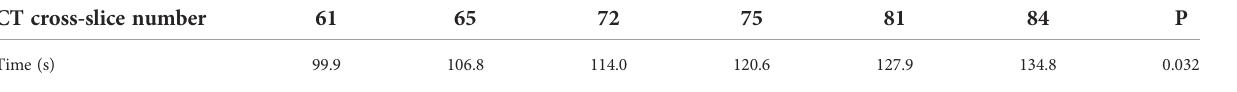
TABLE 8 Time for ABAS automatic contouring among different CT cross-slice numbers. CT cross-slice